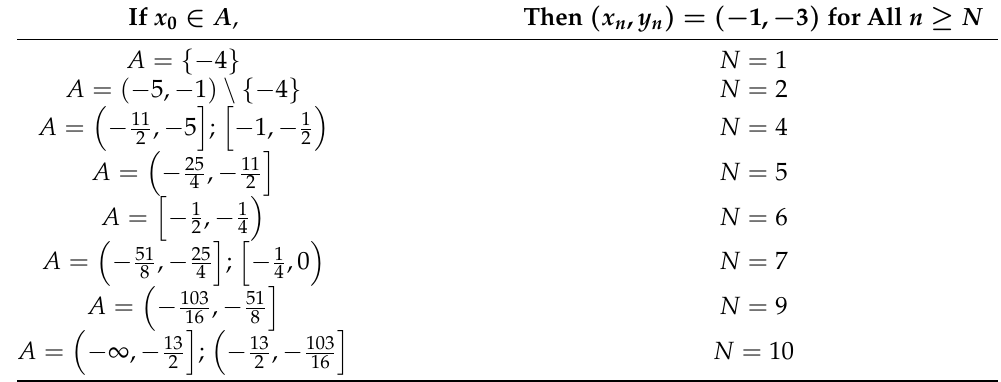
Table 7. Cases for x 0 < 0 and y 0 =